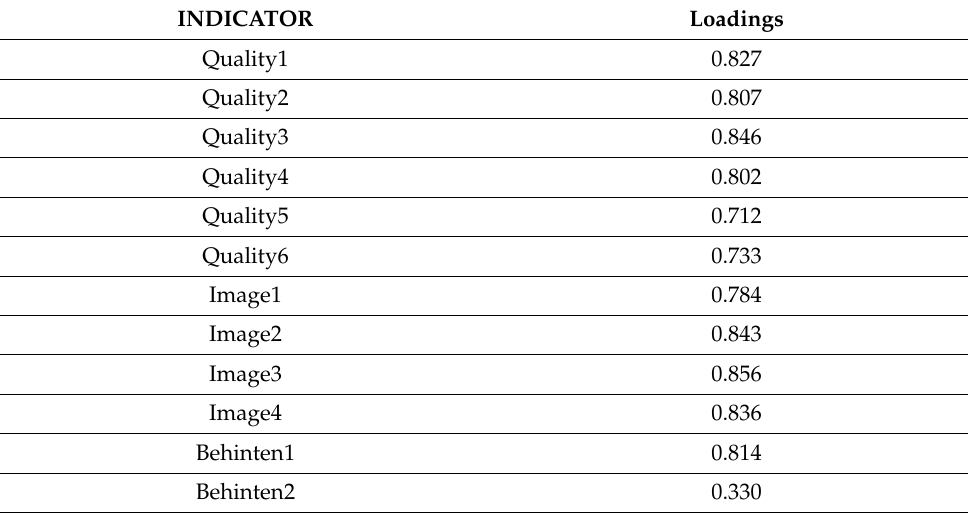
Table 2. Individual reliability